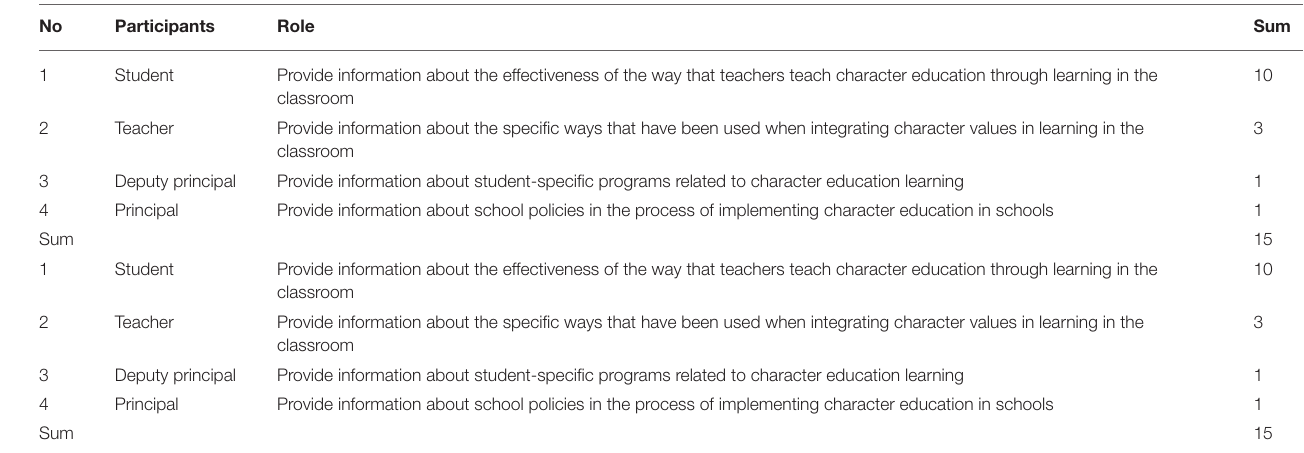
TABLE 1 | Role and number of participants in the